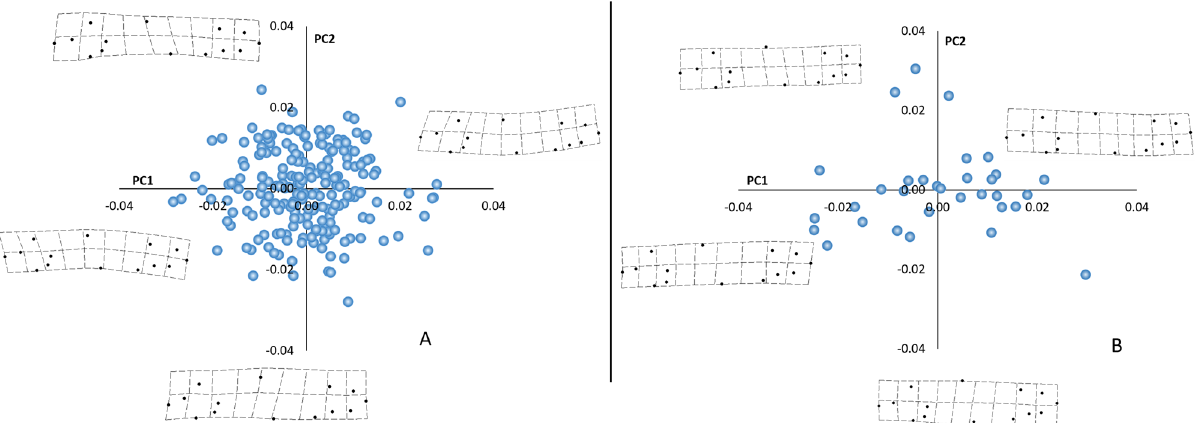
Figure 1. Scores of the PCAs performed on the variances-covariances matrix for the morphological variables. ( A ) PCA for the experimental individuals before release in the Santianes River, and ( B ) PCA for experimental fish recaptured on February, after several months in a natural stream. PC1 negative scores are lower positioned peduncles, PC2 negative scores correspond to deep-bodied and more robust